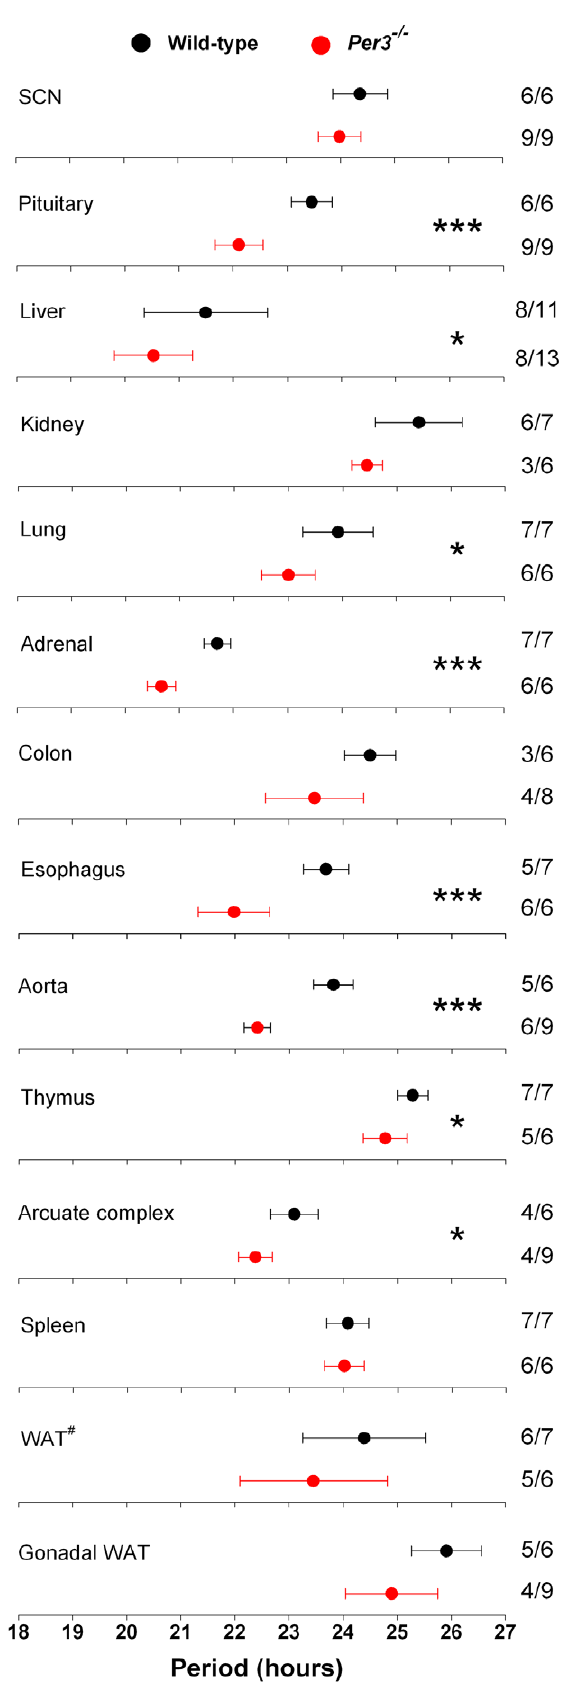
Figure 1. Tissue-specific alterations of circadian periods in Per3 2 / 2 mice. Bioluminescence was recorded from tissue explants prepared from male wild-type (black circles) and Per3 2 / 2 (red circles) mice maintained in 12L:12D. The mean ( 6 SD) periods were determined by fitting regression lines to the acrophases of the PER2::LUC rhythms. The sample size is shown (number of rhythmic tissues/number of tissues tested). WAT # : white adipose tissue surrounding the adrenal gland. * p , 0.05; ** p , 0.01; *** p , 0.001.